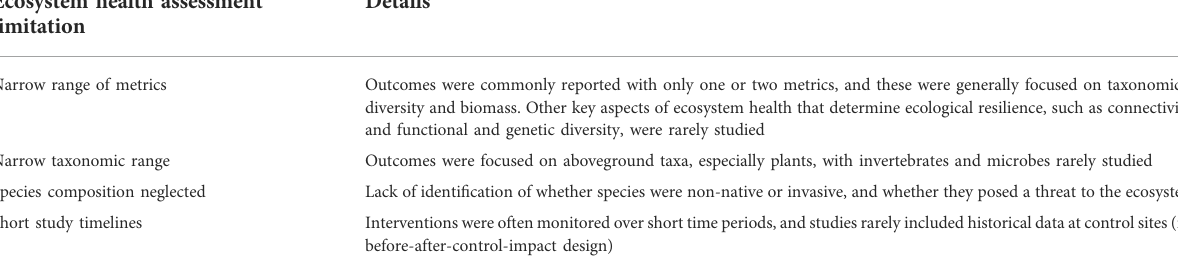
TABLE 5 Summary of limitations to ecosystem health assessments in this